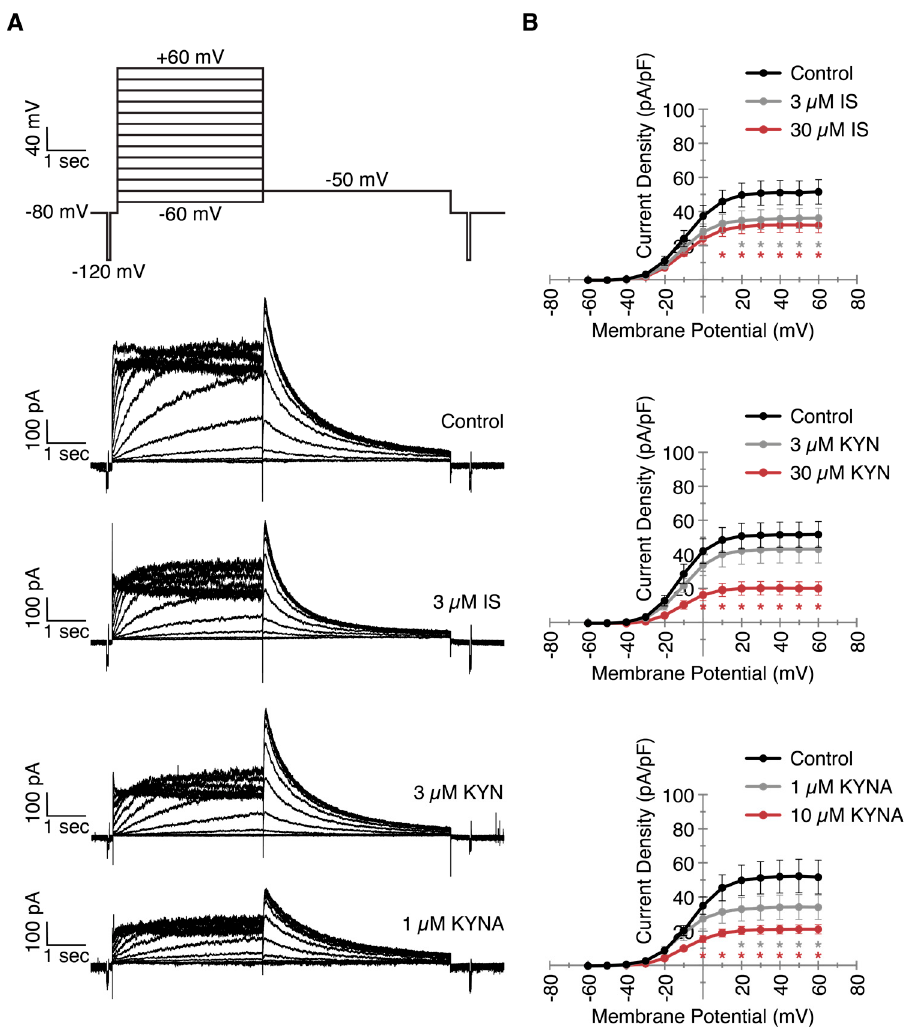
Figure 2. Chronic exposure to uremic toxins decreases I Kr current density. HEK cells stably expressing the hERG ion channel were exposed to two concentrations of indoxyl sulfate (IS), kynurenine (KYN), and kynurenic acid (KYNA) for 48 h. I Kr currents were measured using patch clamp electrophysiology. ( A ) Patch clamp measurement protocol and example traces of control, 3 µM IS, 3 µM KYN, and 1 µM KYNA as clinically relevant concentrations. ( B ) Quantification of all measurements visualized in current-voltage curves. Data are shown as the mean ± SEM. Number of cells = 12–19. * p < 0.05 compared to control.